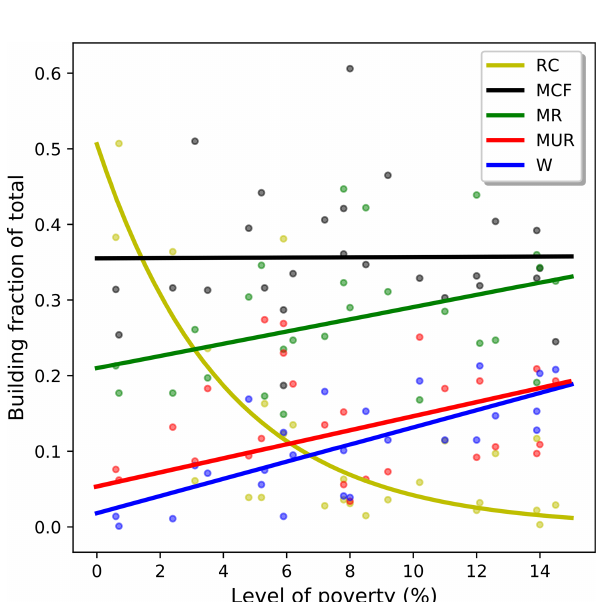
Figure 7. The fraction of residential buildings by building class – RC is reinforced concrete, MCF is confined masonry, MR is rein- forced masonry, MUR is unreinforced masonry, and W is wooden construction – against the proportion of people living below the poverty line in the communes of the Santiago metropolitan region. Solid lines represent best-fit trends through the data (linear for all cases except for reinforced concrete, which is exponential), with coefficients of determination of 0.63, 0.01, 0.45, 0.20, and 0.73 for RC, MCF, MR, MUR, and W respectively. The poverty line is de- fined as USD400 per month for a family of four (Ministerio de Desarrollo Social,